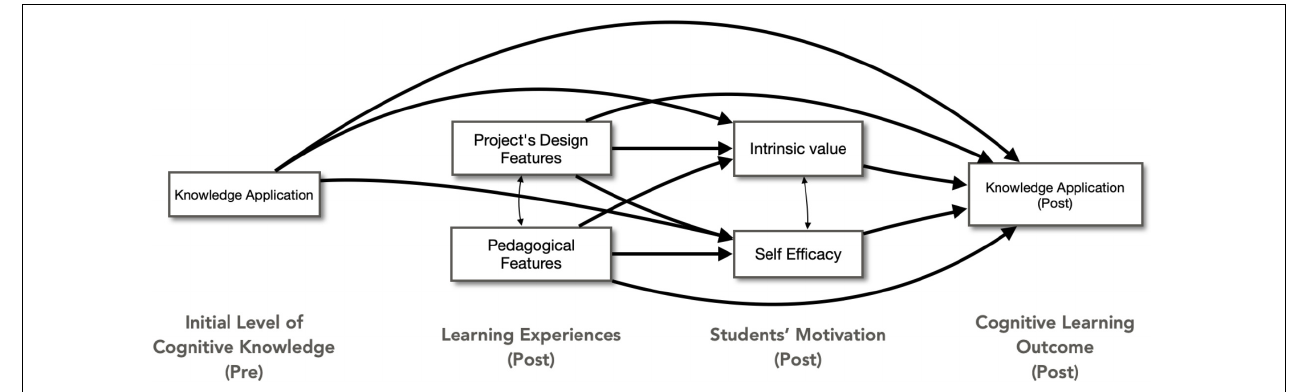
FIGURE 2 | Hypothesized model with